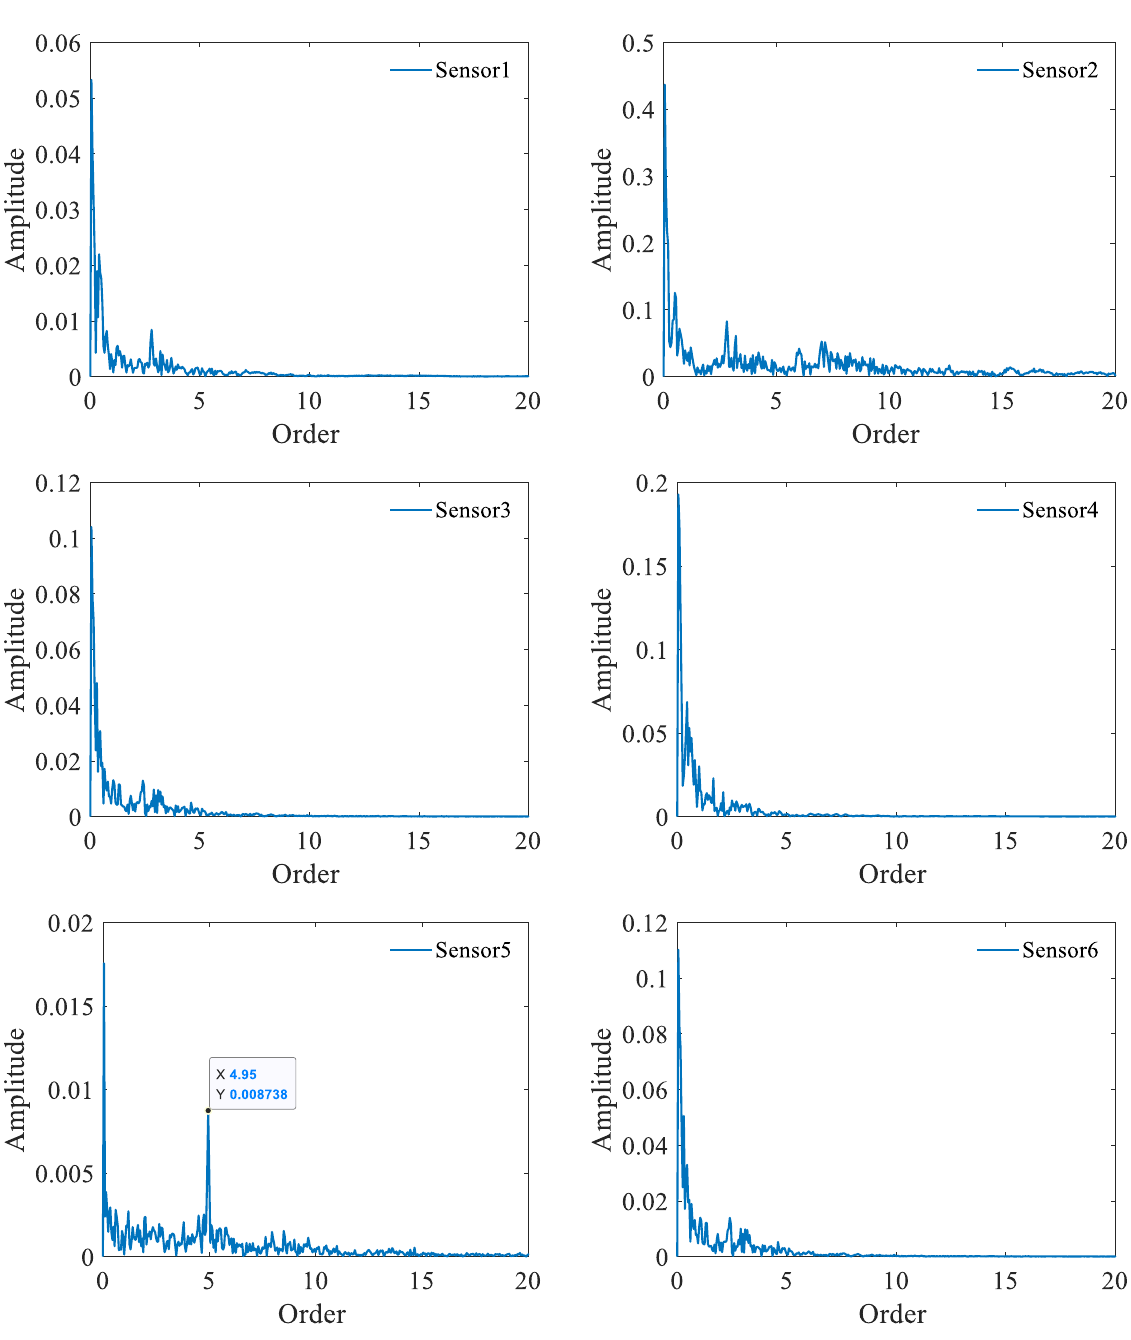
Figure 17. Envelope order spectrums of the collected signals in inner race fault experiment.